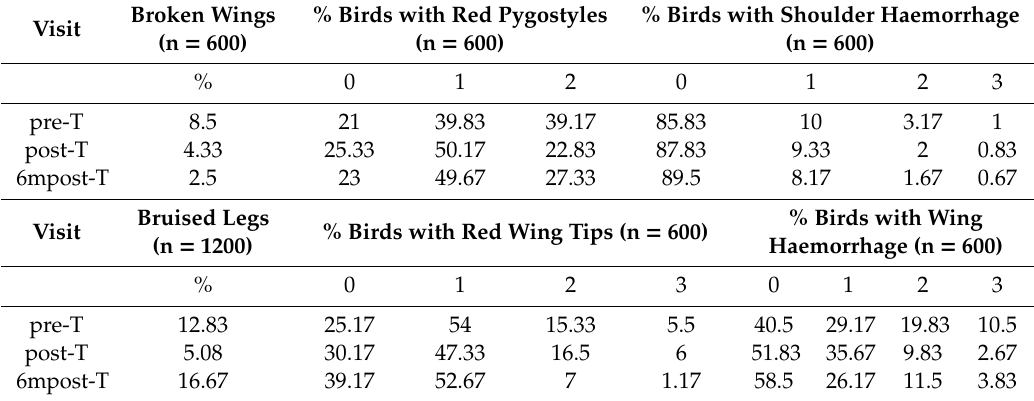
Table 5. The percentage of birds in each visit to processing plant P2 with broken wings, bruised legs and within each external carcass quality class (0–2 or 0–3). Class 0 indicates no visible damage and class 1 indicates a low level of damage which will not result in downgrading while classes 2 and 3 indicate damage which will result in carcass downgrading